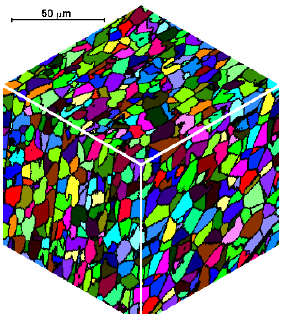
Figure 15. Figure 16 represents space straightening and the microstructure before and after the straightening.